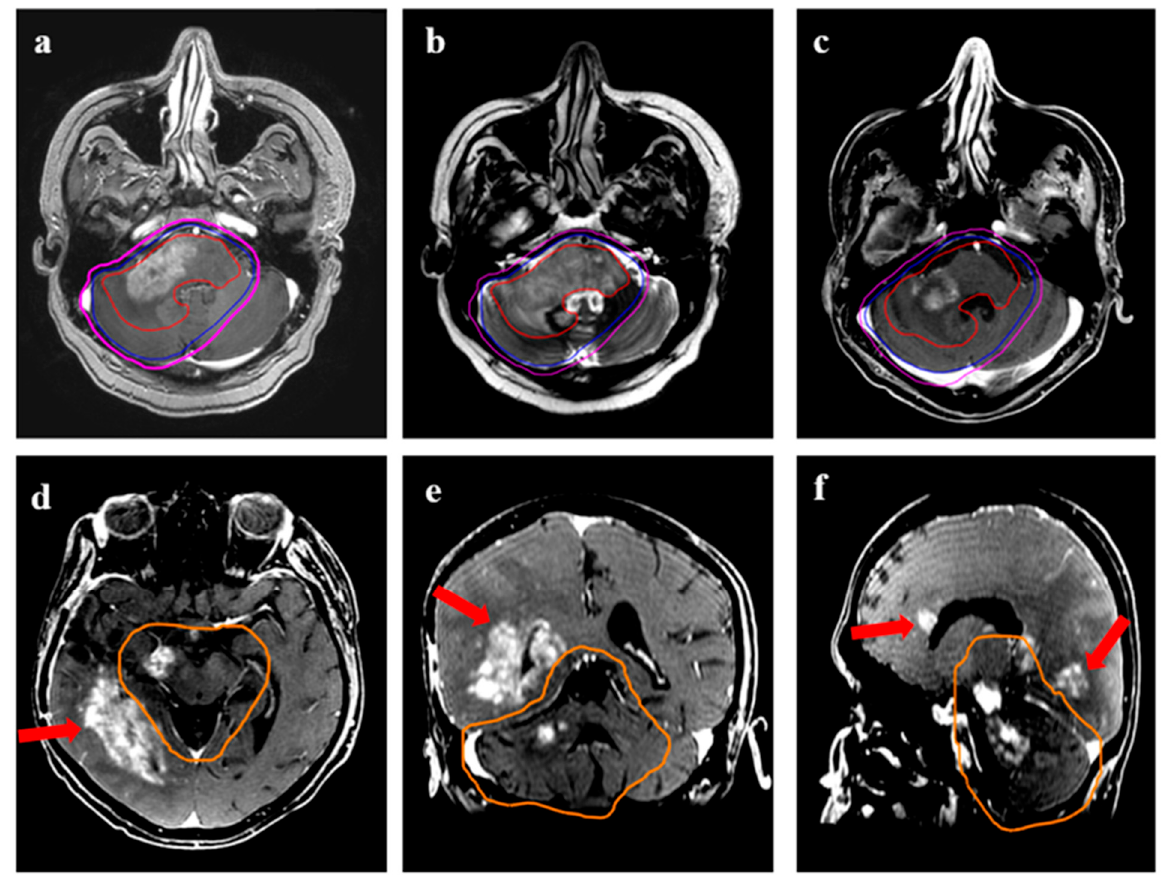
Figure 7. Distant relapse following re-irradiation in a 38-year male with IDH-mutant astrocytoma with transformation (radiological) to grade 4 during reirradiation. ( a , b ) show the target volumes (GTV: red, CTV: blue; PTV: magenta) on T1w contrast and T2w images. The GTV encompassed all the T2w altered signals, including the enhancing disease, while CTV was 10–15 mm expansion along the brain parenchyma. ( c ) represents the response in the primary re-irradiated region 6 months following ReRT, while the lower panel shows axial ( d ), coronal ( e ), and sagittal ( f ) T1w contrast MRI from the same time-point demonstrating distant areas of recurrent disease (arrow) beyond the 95% isodose line (orange). Table 3. Features during recurrence following re-irradiation.